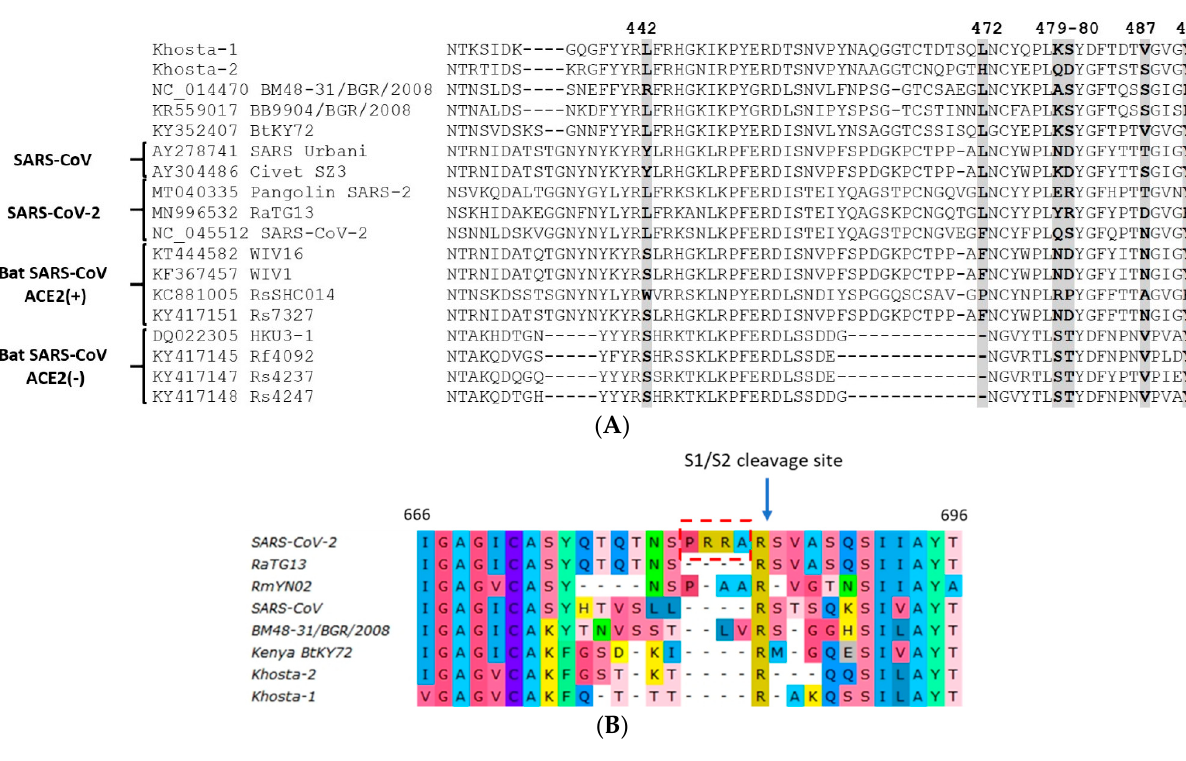
Figure 5. Amino acid alignment of the receptor-binding motif (RBM) of the receptor-binding domain (RBD) of the S protein of Khosta-1 and Khosta-2 of certain sarbecoviruses. Five positions (442, 472, 479, 480, and 487; SARS-CoV Urbani numbering) in the RBM that are thought to be important for adaptation of SARS-CoV-like viruses to the human ACE2 receptor [17] are shown in bold. Bat SARS-CoV-like viruses that are capable or incapable of utilizing the ACE2 receptor are marked with “ACE2(+)” or “ACE2( − )”, respectively ( A ). Amino acid alignment of the region around the S1/S2 cleavage site in SARS-CoV-2, SARS-CoV, Khosta-1, Khosta-2, and certain bat SARS-CoV-like viruses. Four-amino acids insertion (PRRA) that forms polybasic furin cleavage site in SARS-CoV-2 is highlighted with a red border ( B ).